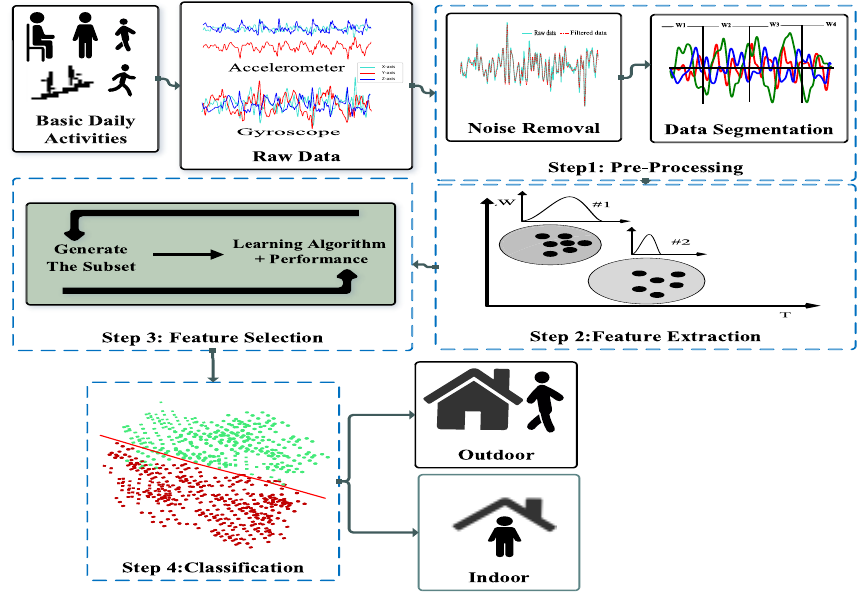
Figure 1. The general schema of the proposed framework.